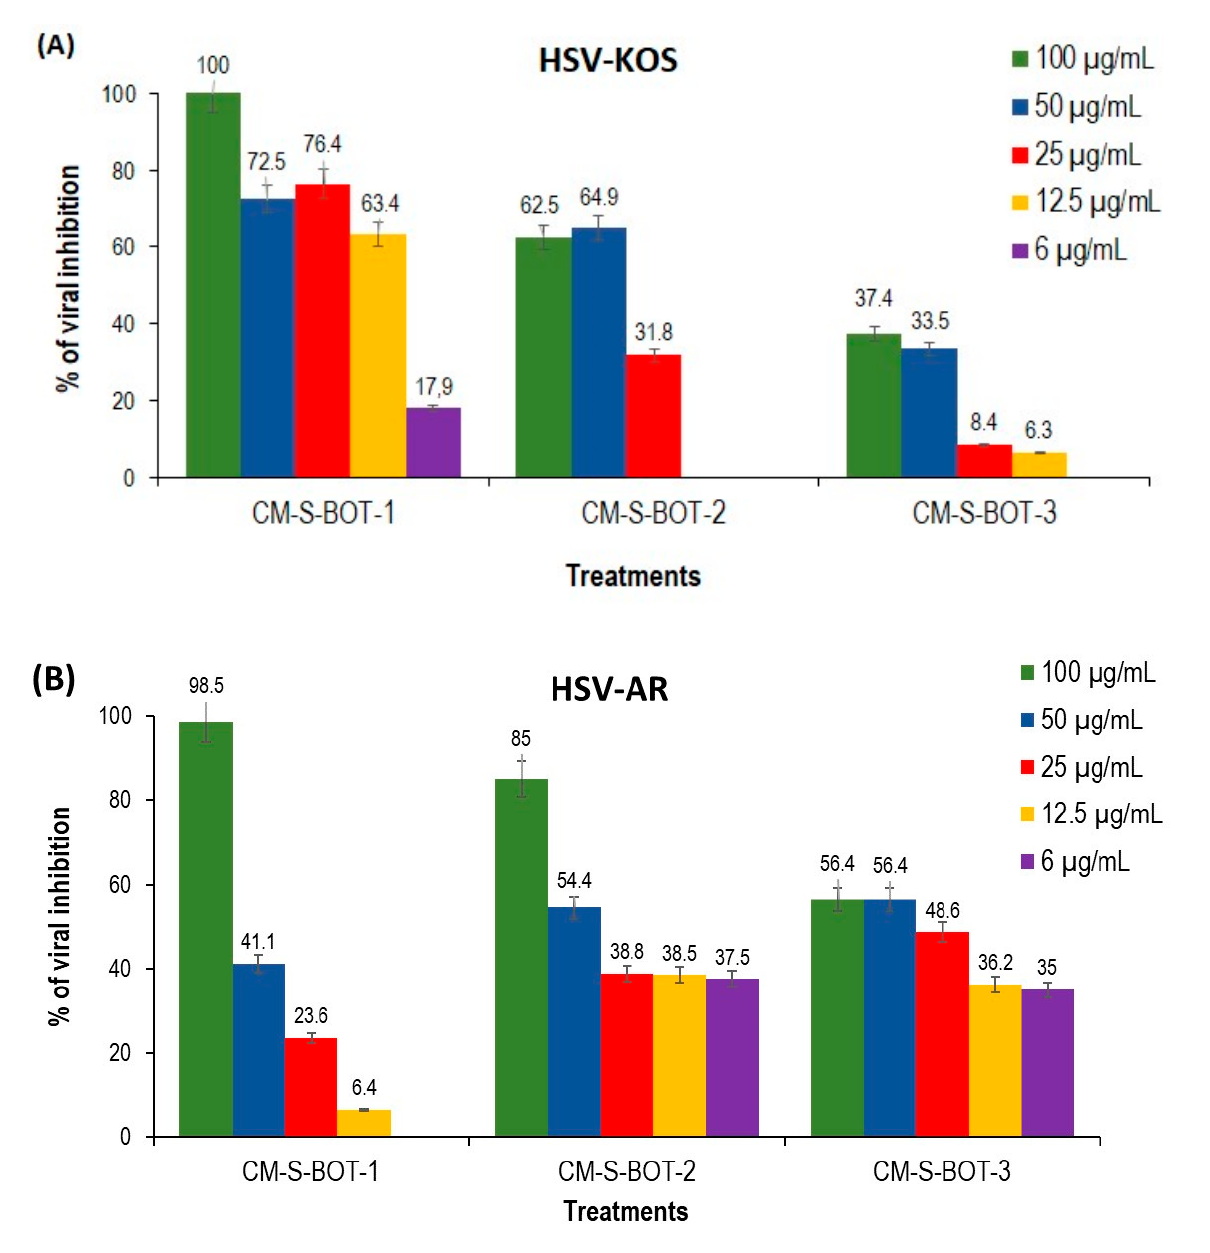
Figure 6. Inhibition of HSV-KOS ( A ) and HSV-AR ( B ) by decreasing concentrations of CM-S-BOT-1, CM-S-BOT-2, and CM-S-BOT-3. Mean ± standard error of the mean ( n = 6); The differences in % of viral inhibition were statistically significant compared to infected and untreated cells ( p < 0.05).